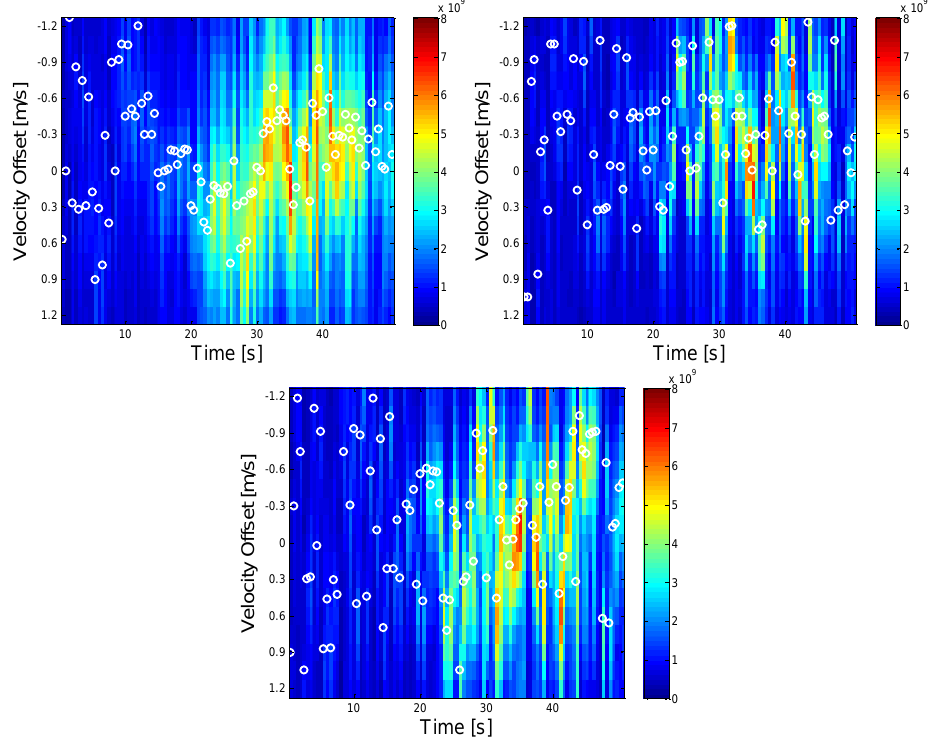
Figure 9. Power distributions in east, north and up velocity domains ( top left , top right and bottom )–Scenario B.